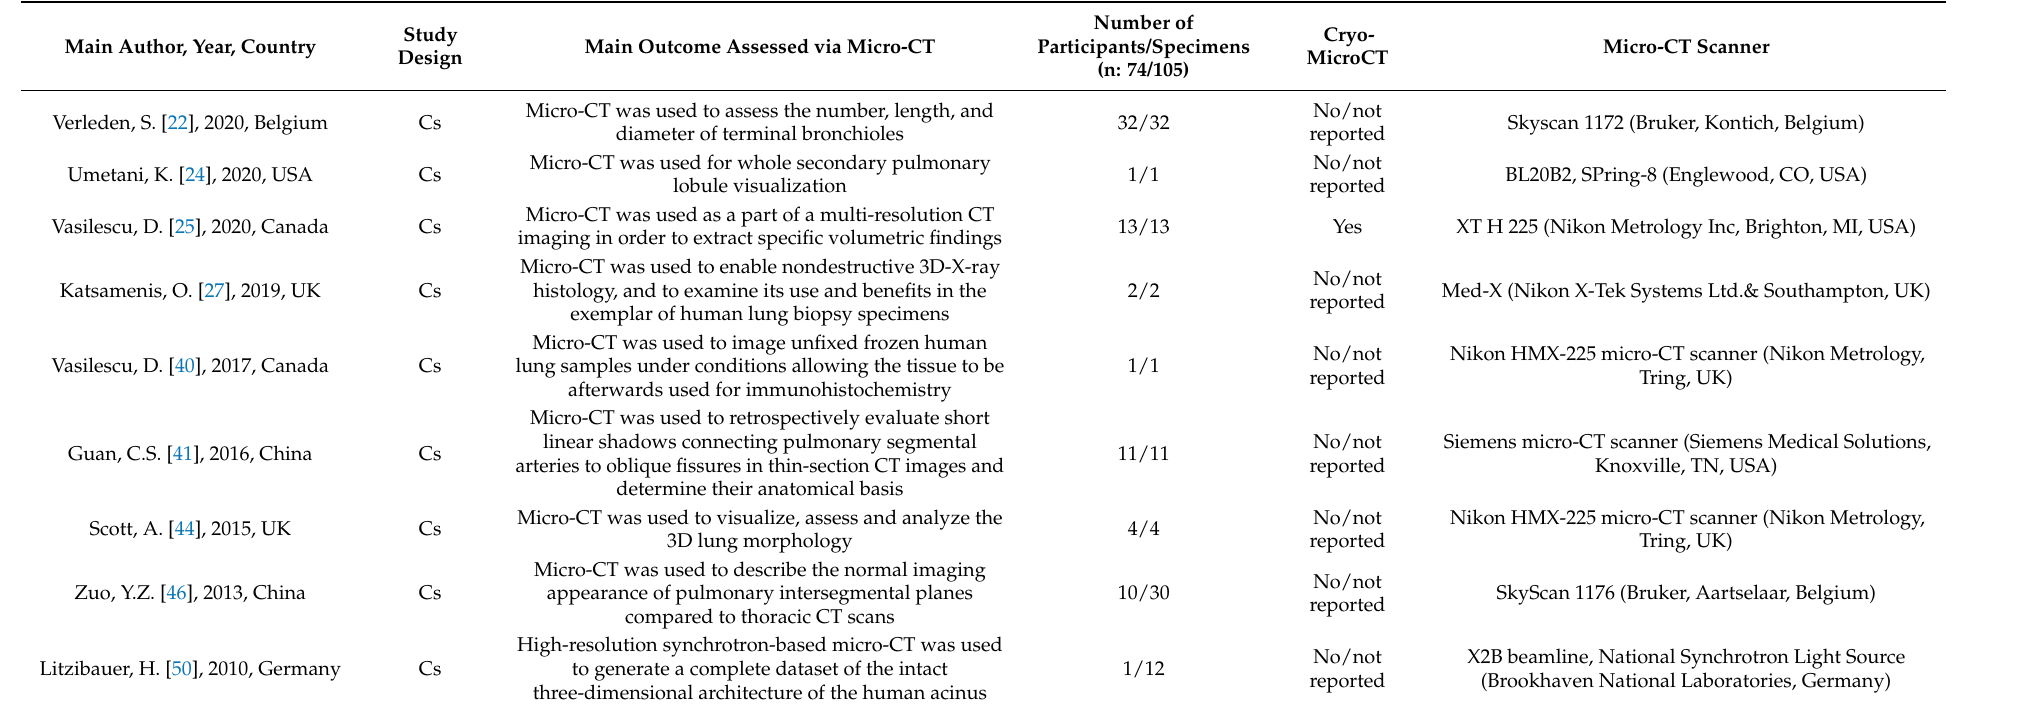
Table 2. Studies using micro-CT for visualization and assessment of the pulmonary